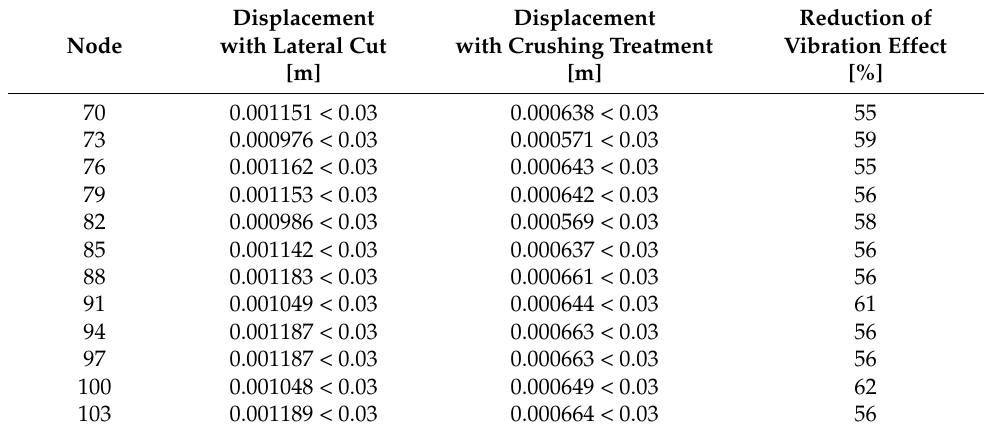
Table 5. Values of δ 0 obtained in the control points and comparison with δ lim